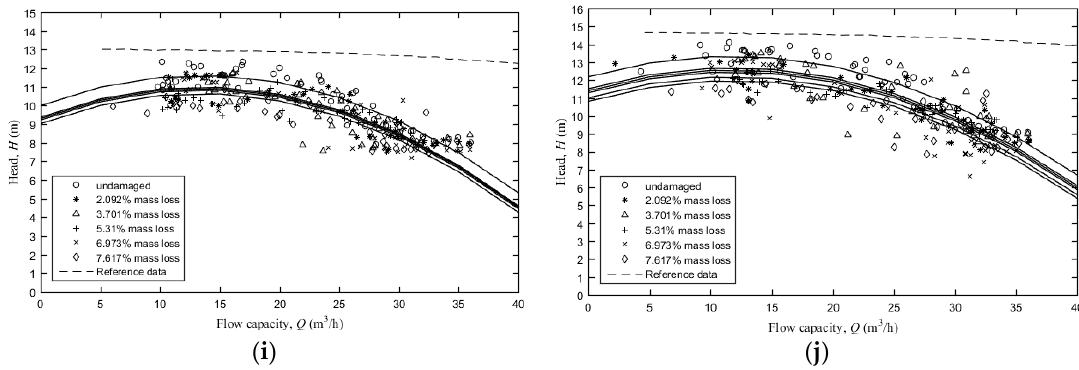
Figure 9. Pump head curves of damaged impellers for different rotational speed with water carried: ( a ) 850 rpm; ( b ) 950 rpm; ( c ) 1050 rpm; ( d ) 1150 rpm; ( e ) 1250 rpm; ( f ) 1350 rpm; ( g ) 1450 rpm; ( h ) 1550 rpm; ( i ) 1650 rpm; ( j ) 1750 rpm.